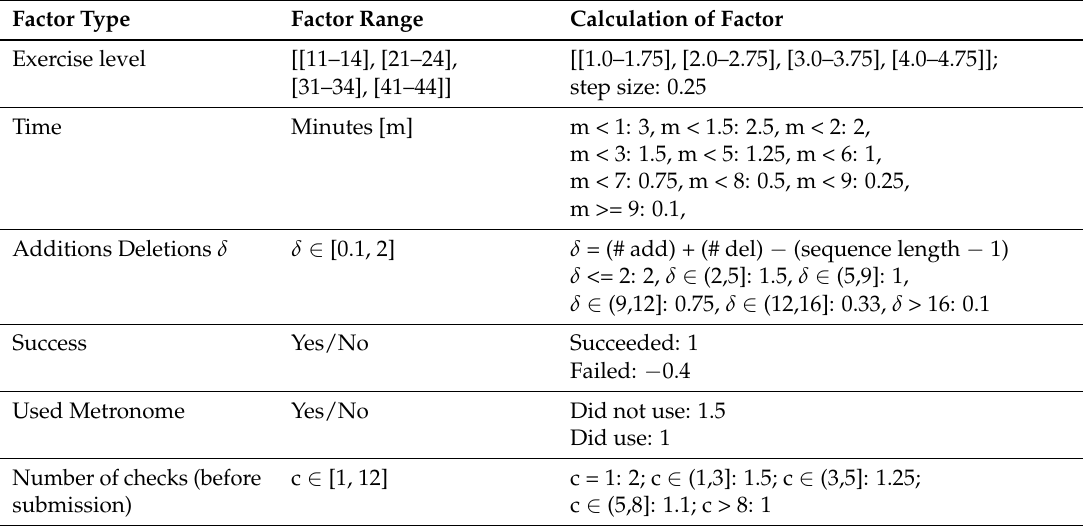
Table 1. Factor types and ranges for calculating the individual exercise